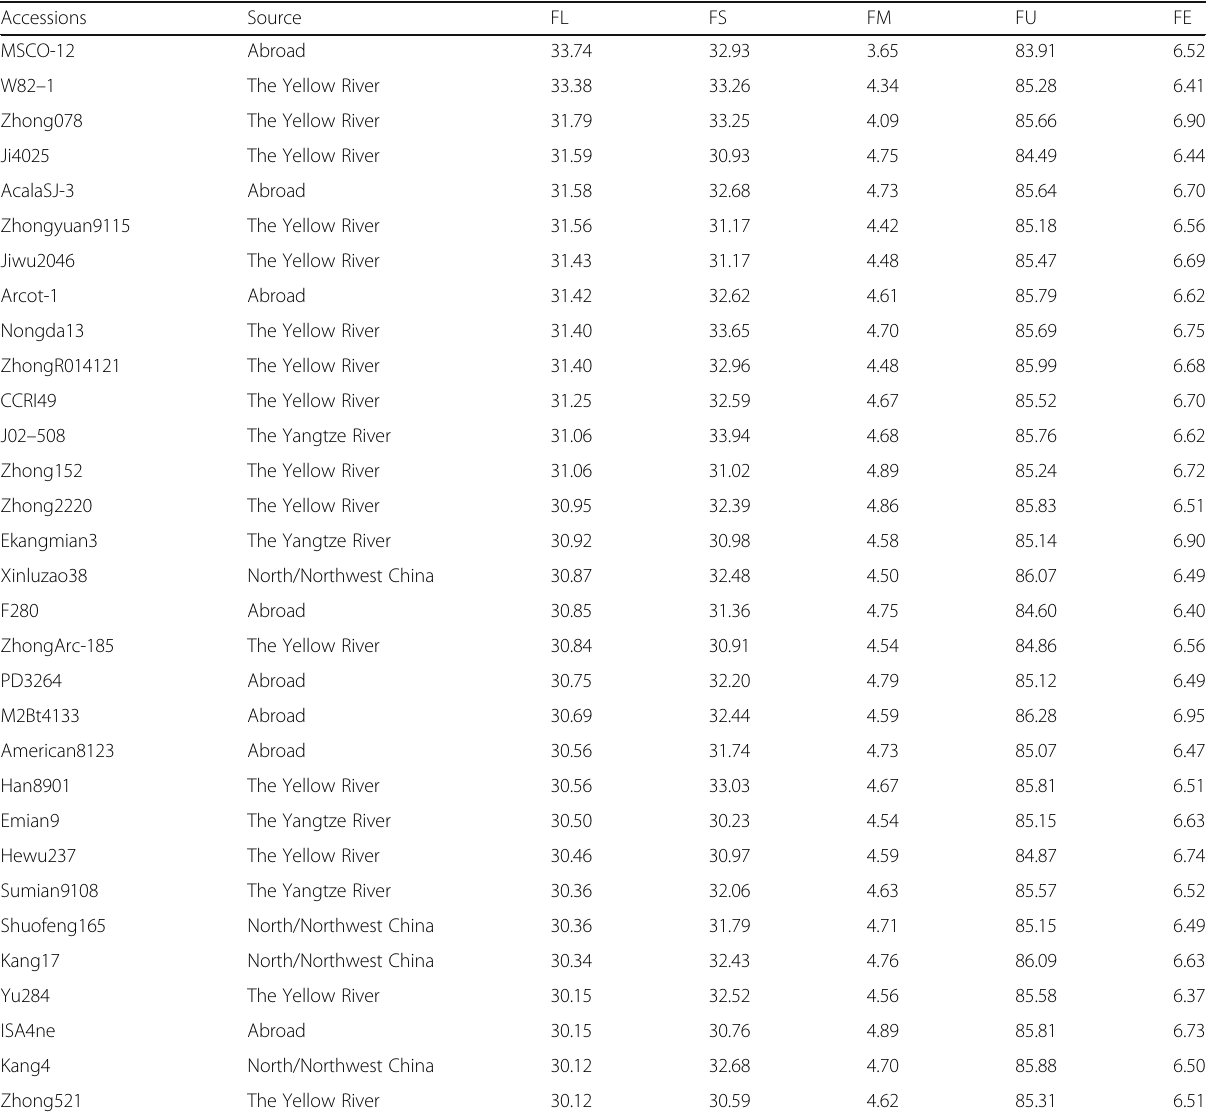
Table 2 The 31 elite upland cotton germplasms screened based on phenotypic traits